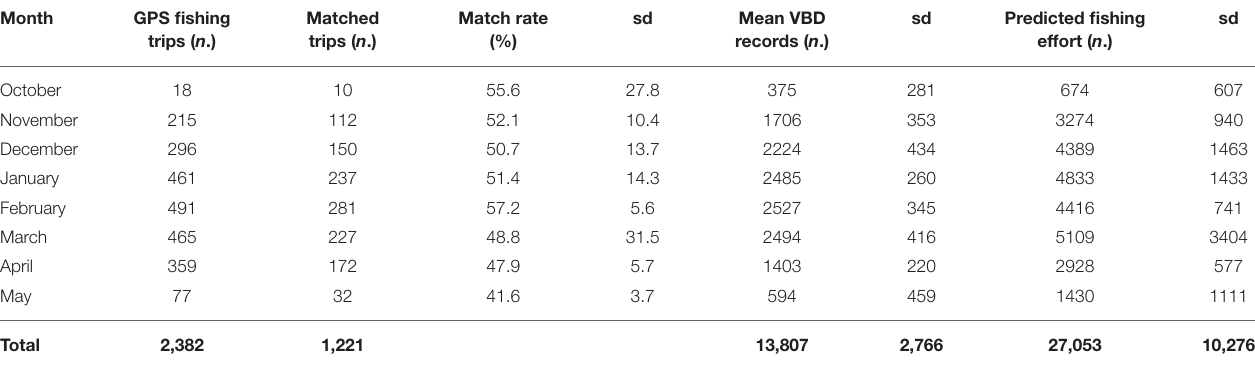
TABLE 3 | Cross matching GPS and VBD data to predict total fishing effort. Month GPS fishing trips ( n .)